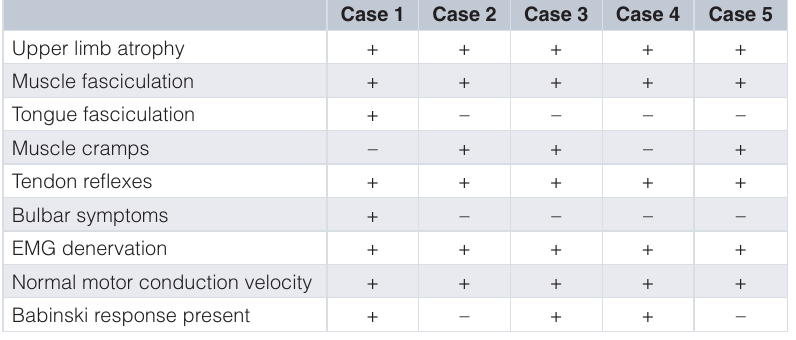
Table 2. Summary of ALS symptoms in five reported cases of syphilitic ALS 4